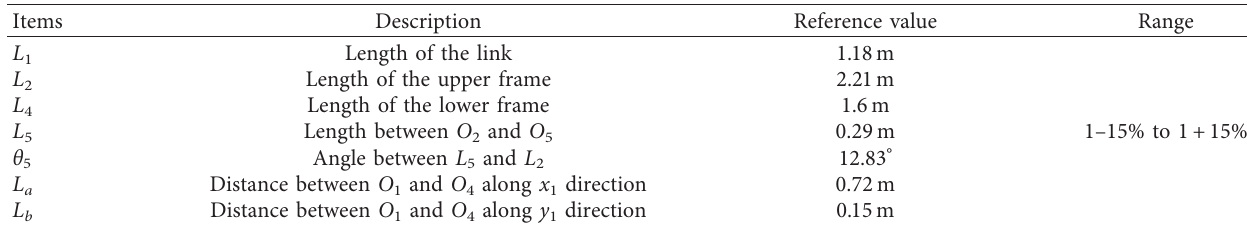
Table 3: Initial size